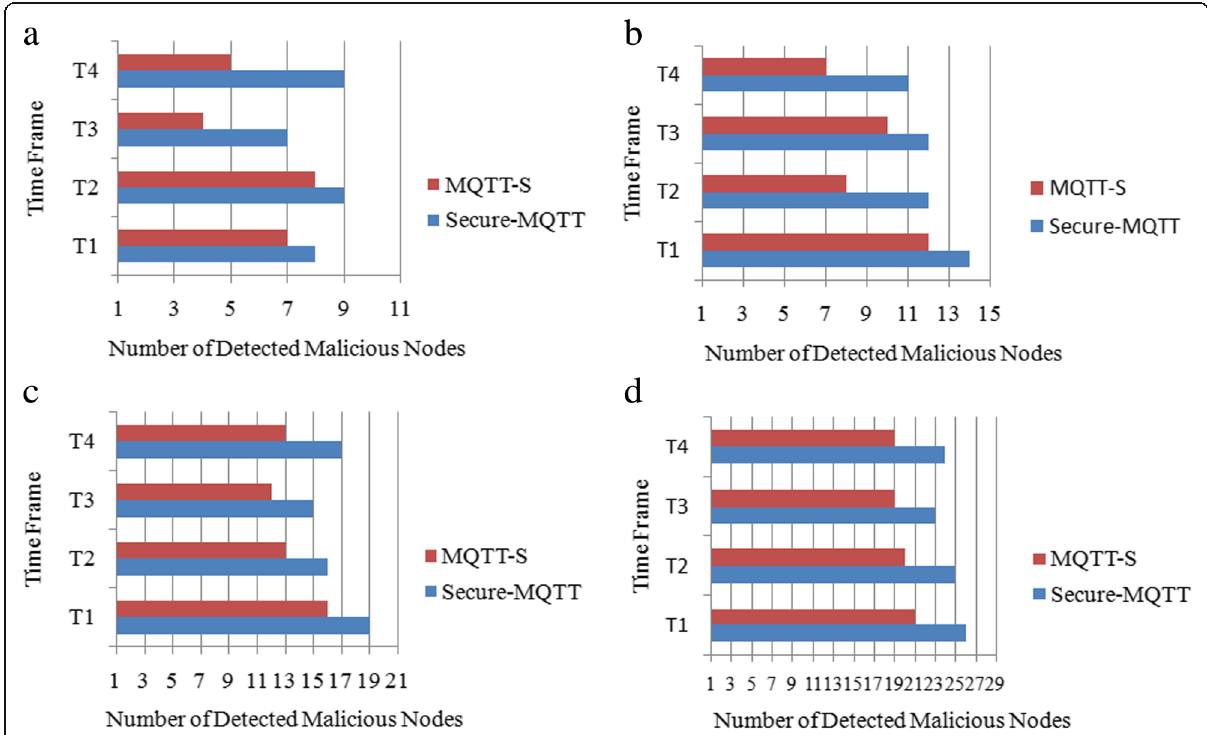
Fig. 9 Attack detection efficiency of a 100, b 150, c 200, and d 300 nodes